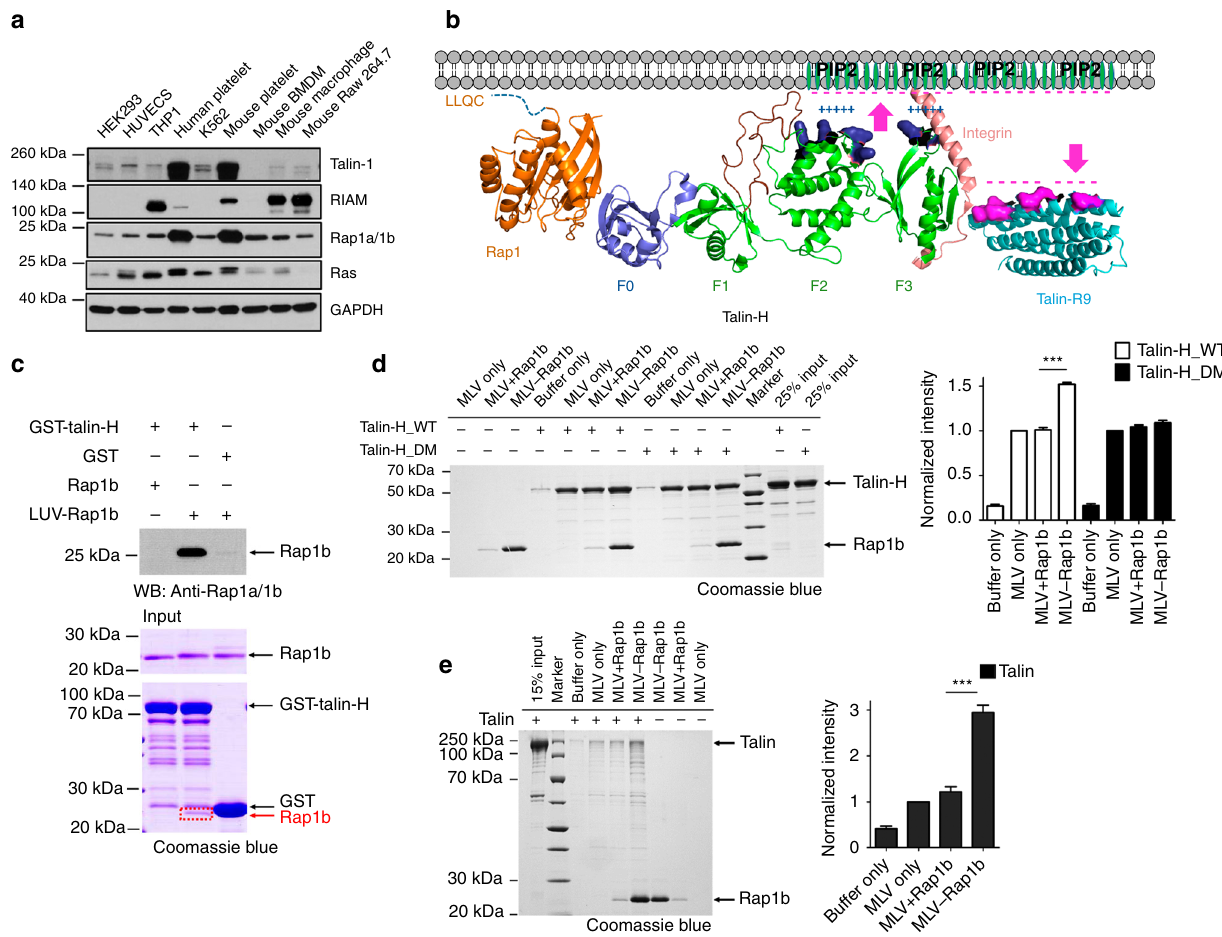
Fig. 6 Mechanism of talin recruitment by Rap1. a Protein expression levels of talin, RIAM, Rap1, Ras GTPases, and GAPDH in various types of cell lines indicated in the fi gure. Full blots are shown in Supplementary Fig. 13. b A model of membrane-associated Rap1b recruiting talin for integrin activation. Proteins are shown in cartoon representation. Talin F1 loop is colored in maroon, the positively charged residues of talin-F2F3 domains (green), which interact with PIP2, are colored in deep blue and shown in surface representation, and the negatively charged residues of talin-R9 (cyan) are colored in magenta and shown in surface representation. c GST pull-down assay to show the robustly enhanced interaction between membrane-anchored Rap1b and talin-H. Rap1b was loaded with GMP-PNP in this assay and “ LUV-Rap1b ” represents that Rap1b was anchored to large unilamellar vesicles (LUVs). LUV- Rap1b could be easily pulled down by GST-talin-H and the band was visible in Coomassie blue staining gel (boxed in red) and intense in WB analysis, while free Rap1b pulled down by GST-talin-H was hardly seen in the same condition. Full blot/gel images are shown in Supplementary Fig. 14. d Left, a representative vesicle co-sedimentation assay showing that the interaction between talin-H_WT and membrane is enhanced by around 1.5-folds when Rap1b (GMP-PNP) is attached to membrane but not for talin-H_DM. “ MLV + Rap1b ” represents that Rap1b remained as free form in solution without being attached to multilamellar vesicles (MLVs), which were pre-incubated with β -mercaptoethanol. “ MLV-Rap1b ” represents that Rap1b was anchored to MLVs. Right, the quanti fi cation of four independent experiments. The intensity of talin-H_WT or talin-H_DM band was normalized to that of corresponding “ MLV only ” group and the data are shown in means ± S.E.M. *** p < 0.0001. Full gel image is shown in Supplementary Fig. 15. e Left, a representative vesicle co- sedimentation assay showing that the interaction between full-length talin and membrane is signi fi cantly enhanced by around 3-folds when Rap1b (GMP- PNP) is attached to membrane. Right, the quanti fi cation of four independent experiments. The intensity of talin band was normalized to that of the “ MLV only ” group and the data are shown as means ± S.E.M. *** p < 0.0001. Full gel image is shown in Supplementary Fig.